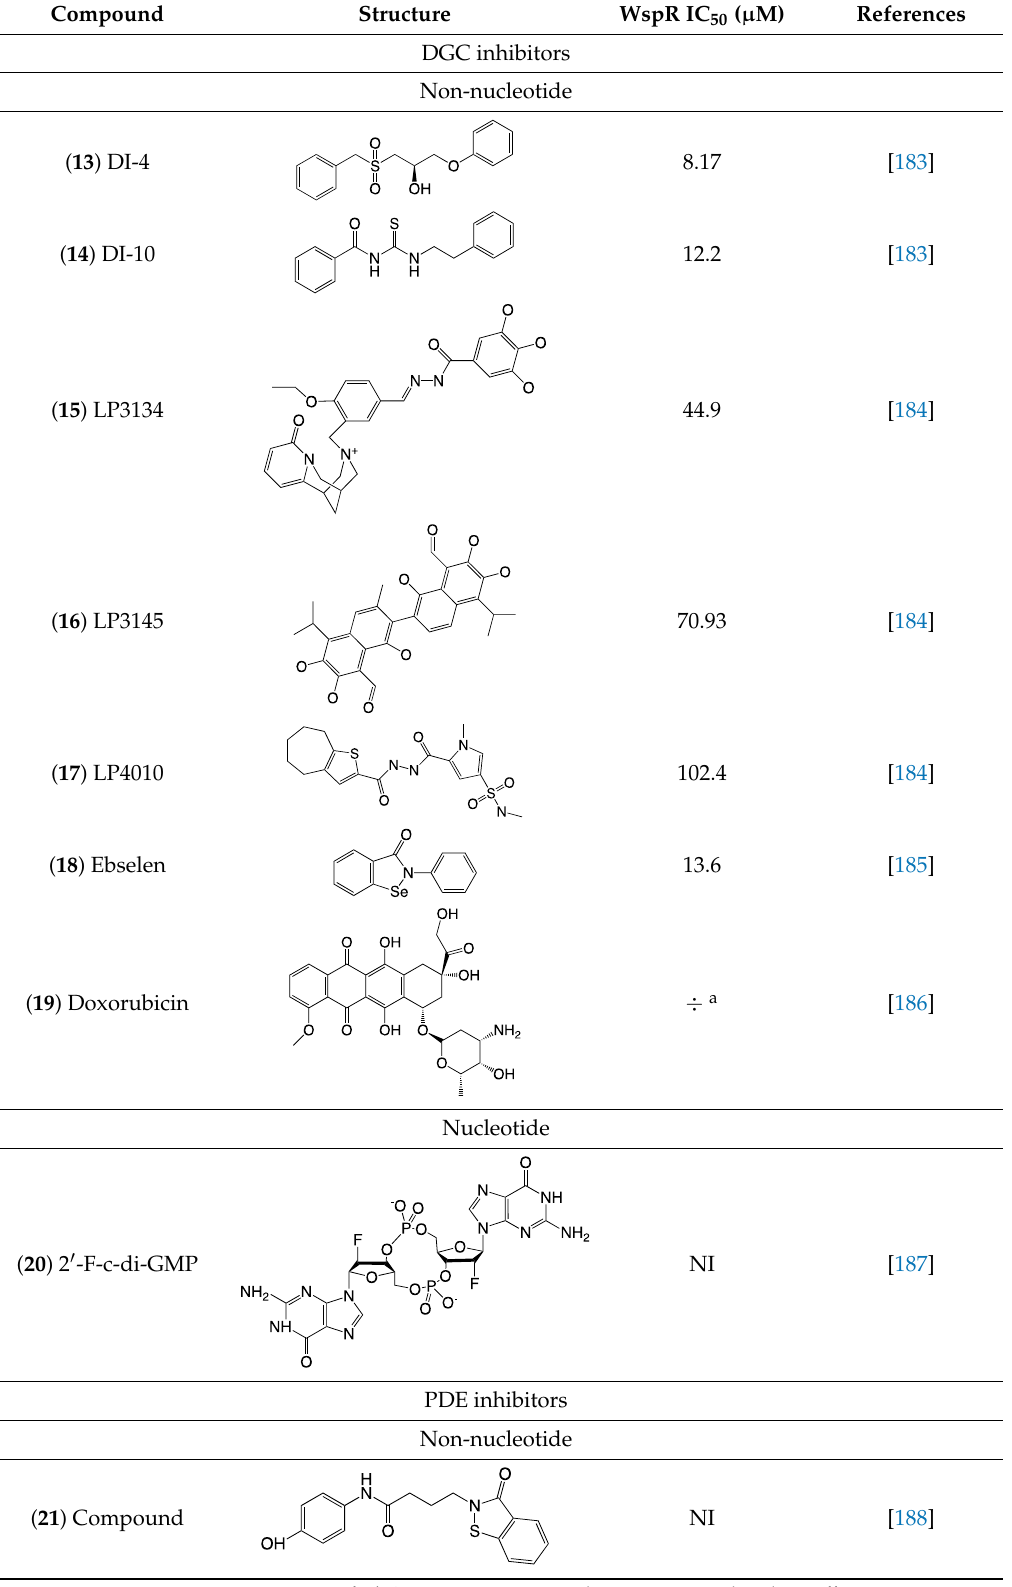
Table 2. Representative non-nucleotide and nucleotide small molecule inhibitors of Pseudomonas